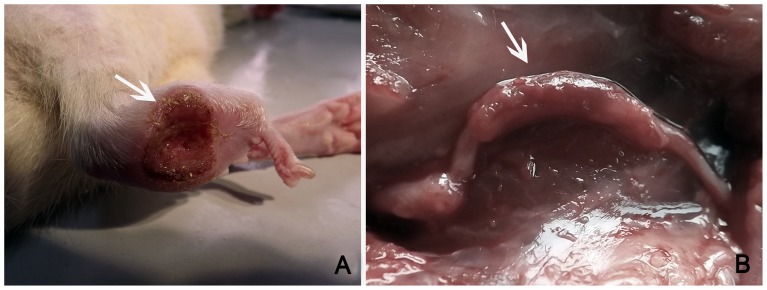
General characteristics.(A: Ulcer that has not yet healed; B: general observations 12 weeks after surgery).